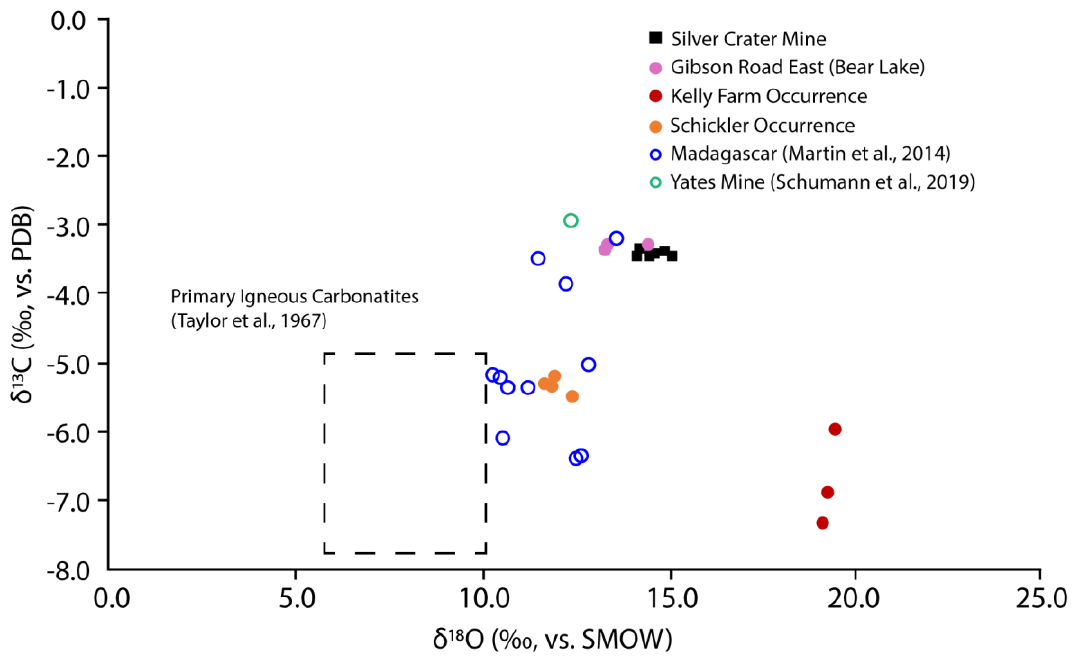
Figure 12. Plot of δ 13 C VPDB vs. δ 18 O VSMOW for calcite from Gibson Road East (Bear Lake), the Schickler Occurrence, the Silver Crater Mine, the Kelly Farm, Madagascar, and the Yates Mine (Table S2). Data points for Madagascan crustal carbonatite deposits include data from Ampandrandava, Benato, Sakamasy, Amboanevo, and Sakaravy [20]. Data for Madagascan localities and the Yates Mine are reported in Martin et al. [20] and Schumann et al. [21], respectively. The range for unaltered primary carbonatites (dashed box) is plotted from the dataset for global carbonatites given in Taylor et al.